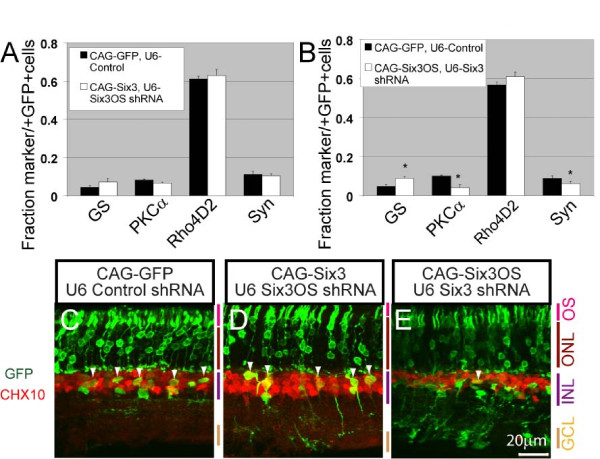
Six3 overexpression rescues the Six3OS knockdown phenotype whereas Six3OS overexpression is not sufficient to rescue the loss of Six3. (A) Six3OS knockdown combined with Six3 overexpression led to a cell type distribution indistinguishable from cells electroporated with control constructs when tested by immunostaining of dissociated electroporated retinal cells. (B) Six3 knockdown combined with Six3OS overexpression led to an increase in Muller glia and a decrease in rod bipolar cells and a decrease in syntaxin (Syn)-positive amacrine cells. GS, glutamine synthetase. (C-E) Section immunohistochemistry of retinas confirm a distribution of GFP-positive cells that is indistinguishable from controls when Six3OS knockdown is combined with Six3 overexpression, while Six3 knockdown and Six3OS overexpression led to a decrease in bipolar cells (F, white arrowheads). GCL, ganglion cell layer; INL, inner nuclear layer; ONL, outer nuclear layer; OS, outer segment.